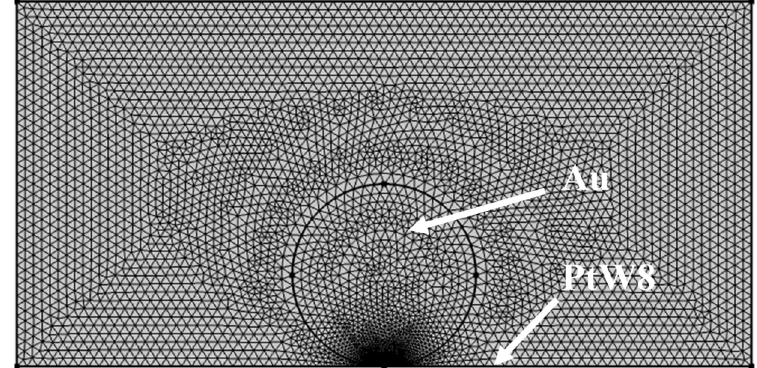
Figure 13. Finite element model of the spreading